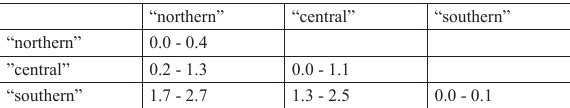
Table 4. AMOVA. In the AMOVA the populations correspond to the individuals collected at each locality, respectively, and the groups correspond to the geographically separated groups A) ”northern–central” and “southern” ( F = 0.896 (p = 0.000) and F ern”, “central” and “southern” ( F